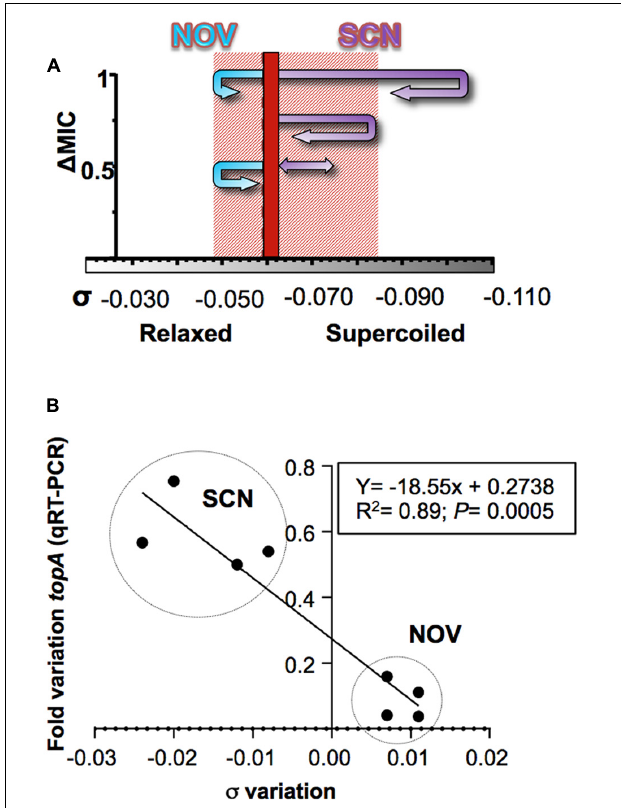
FIGURE 8 | Responses to changes in supercoiling are conducted by Topo I. (A) Diagram showing the trajectory of the supercoiling density at the indicated NOV and SCN concentrations. A dashed line indicates the supercoiling density of DNA of non-treated cells. The shaded area represents the supercoiling density interval in which cells can survive. (B) Correlation between changes in supercoiling level and the transcription of topA . The data correspond to samples treated with either SCN or NOV at concentrations that allowed cell growth and the recovery of DNA supercoiling. Taken from Ferrándiz et al. (2016a), with